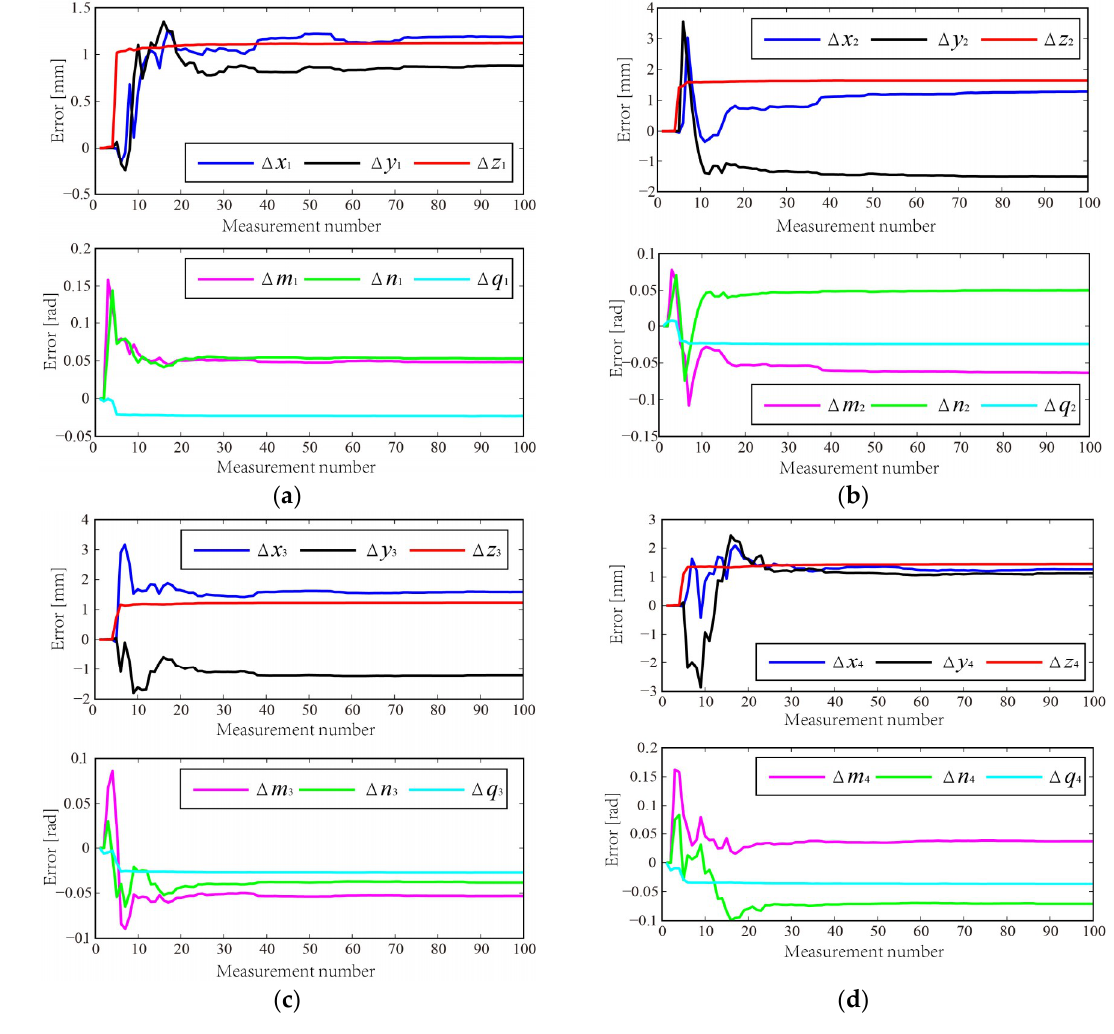
Figure 7. Estimated parameter errors of four laser displacement sensors using EKF algorithm. Table 3. The numbers of convergence measurement points for each laser.